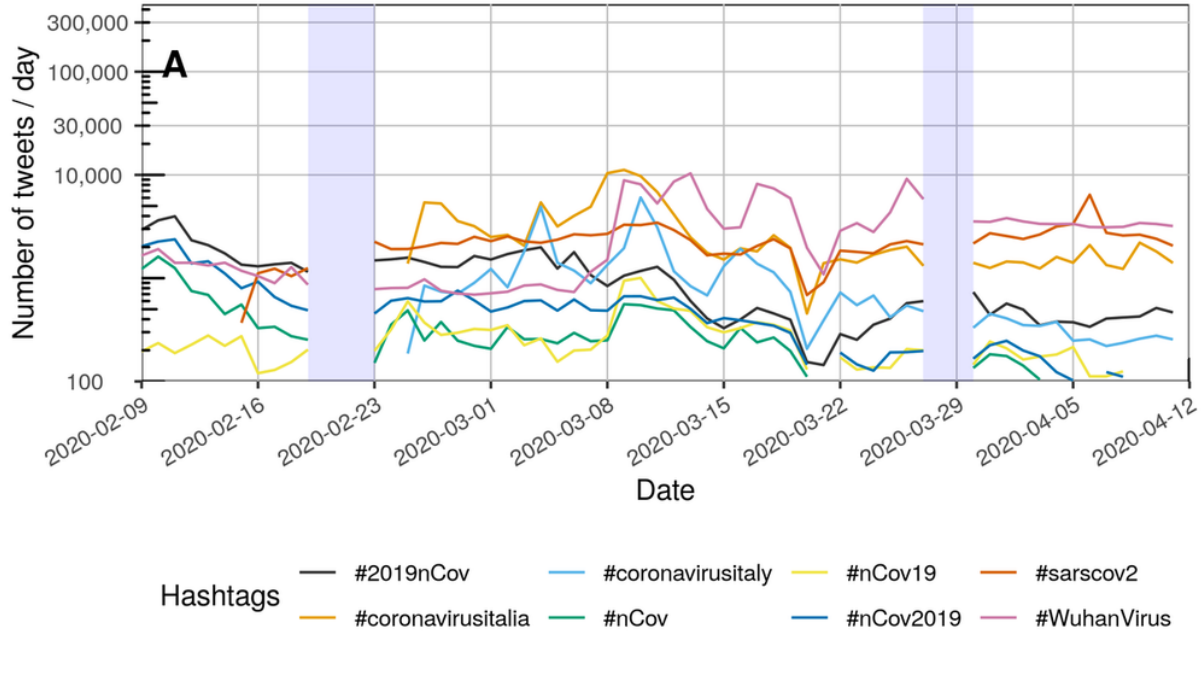
Figure 3. Number of tweets per day for the hashtags ranked 9-16 (see Table 2) between February 9, 2020, and April 11, 2020, on a logarithmic scale. The capital letter "A" represents the naming of the disease by the World Health Organization on February 11, 2020. Blue rectangles: No tweets were collected between February 20 and 22 as well as between March 28 and 29 due to technical